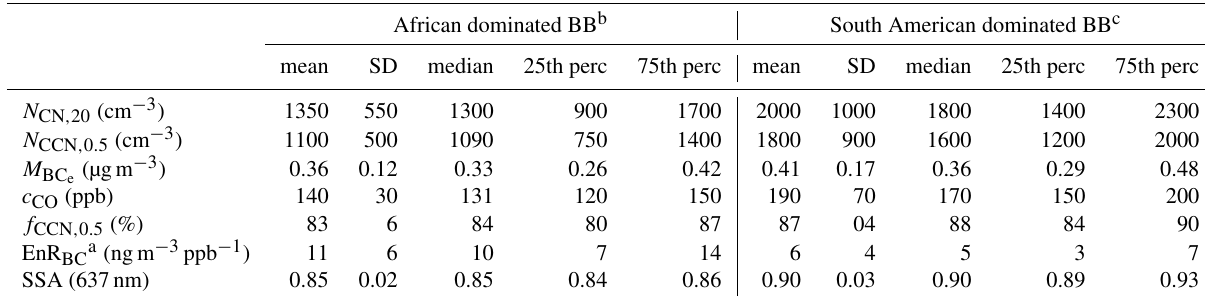
Table 3. Characteristic aerosol and trace gas concentrations during the African vs. South American dominated periods of the BB season at the ATTO site: arithmetic mean ± SD, median and inter-quartile range of daily averages from 2013 to